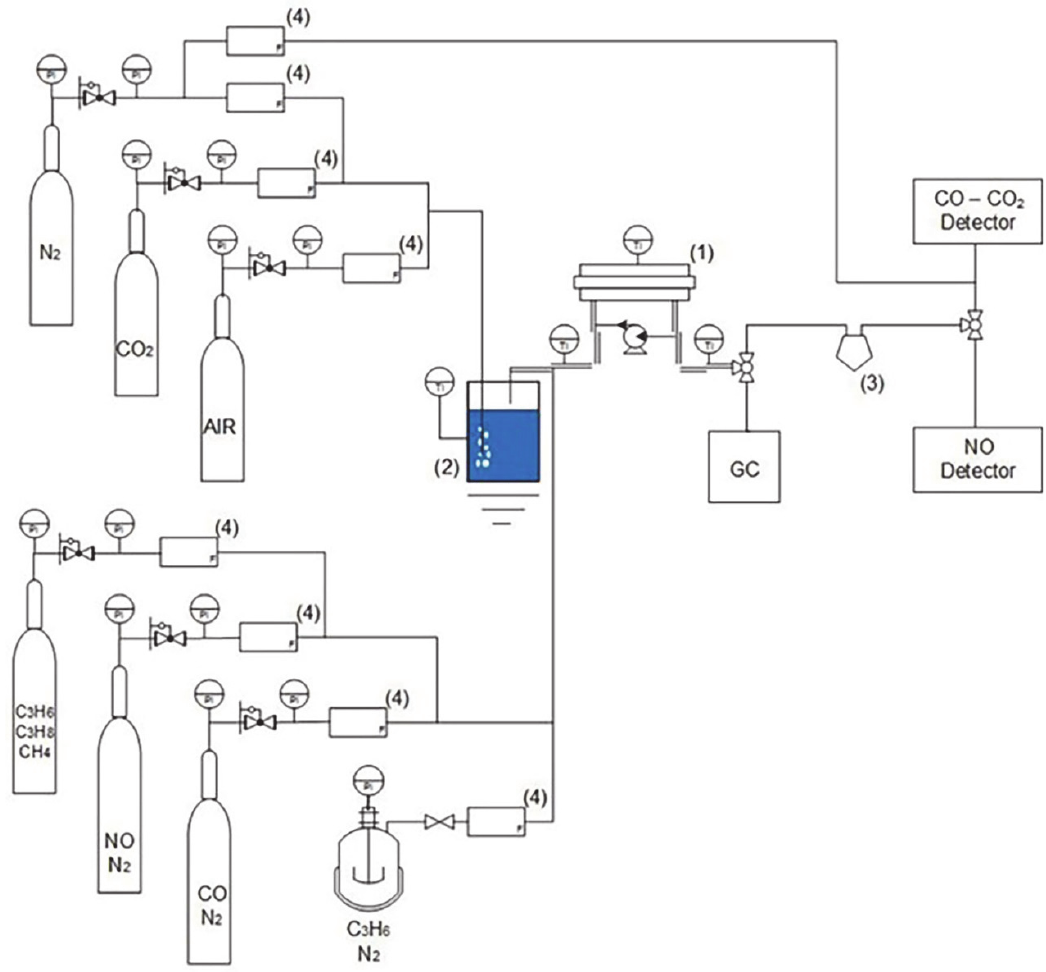
Figure 7. The experimental apparatus: ( 1 ) reactor, ( 2 ) thermostatic water bubbler, ( 3 ) water trap, and ( 4 ) mass flow controllers. (Reprinted with permission from Ref. [103]. Copyright 2017, copyright Elsevier).